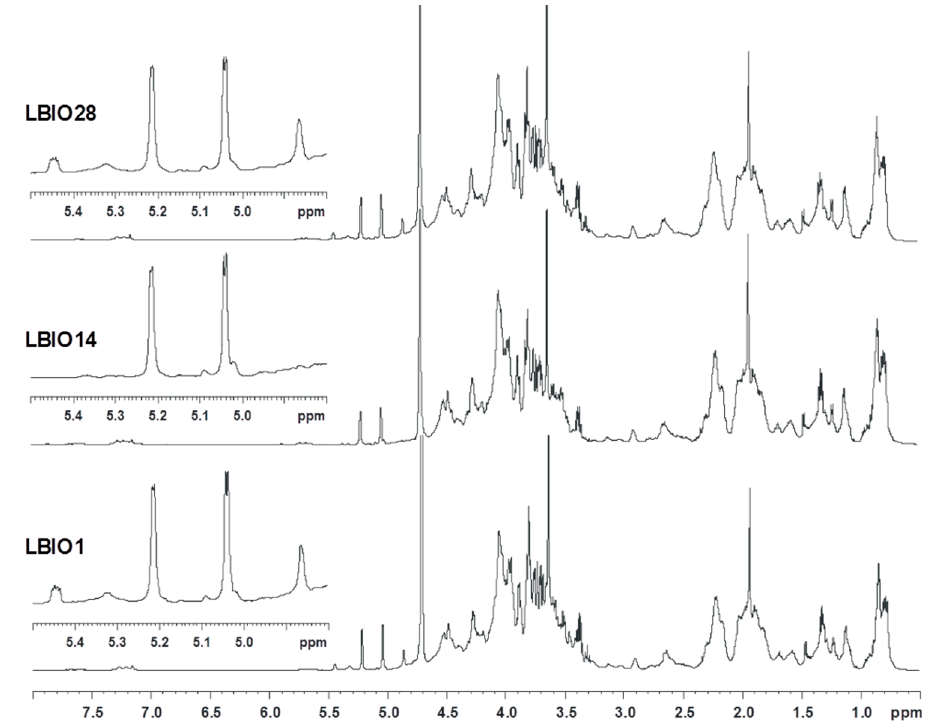
Figure 3. Proton spectra measured by nuclear magnetic resonance (+H-NMR) for the EPSs purified from milks fermented with L. plantarum LBIO1, LBIO14 or LBIO28. The anomeric region corresponding with EPSs is enlarged in the left corner of the spectra (amplified range 5.5–4.8 ppm).